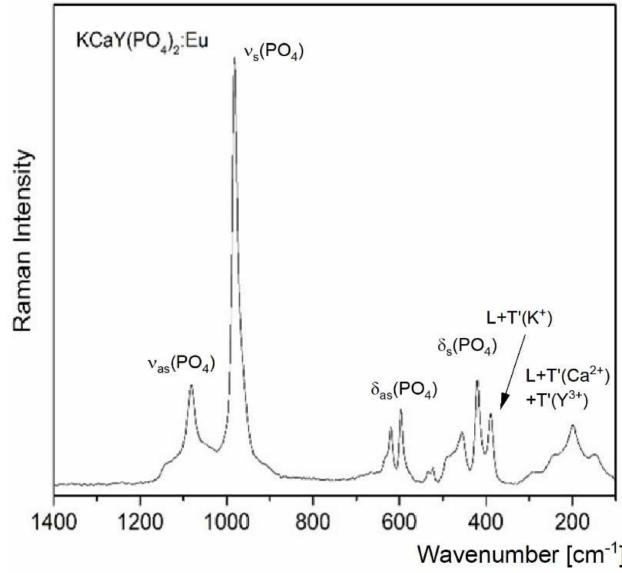
Figure 7. Raman spectra of KCaY(PO 4 ) 2 :5% Eu 3+